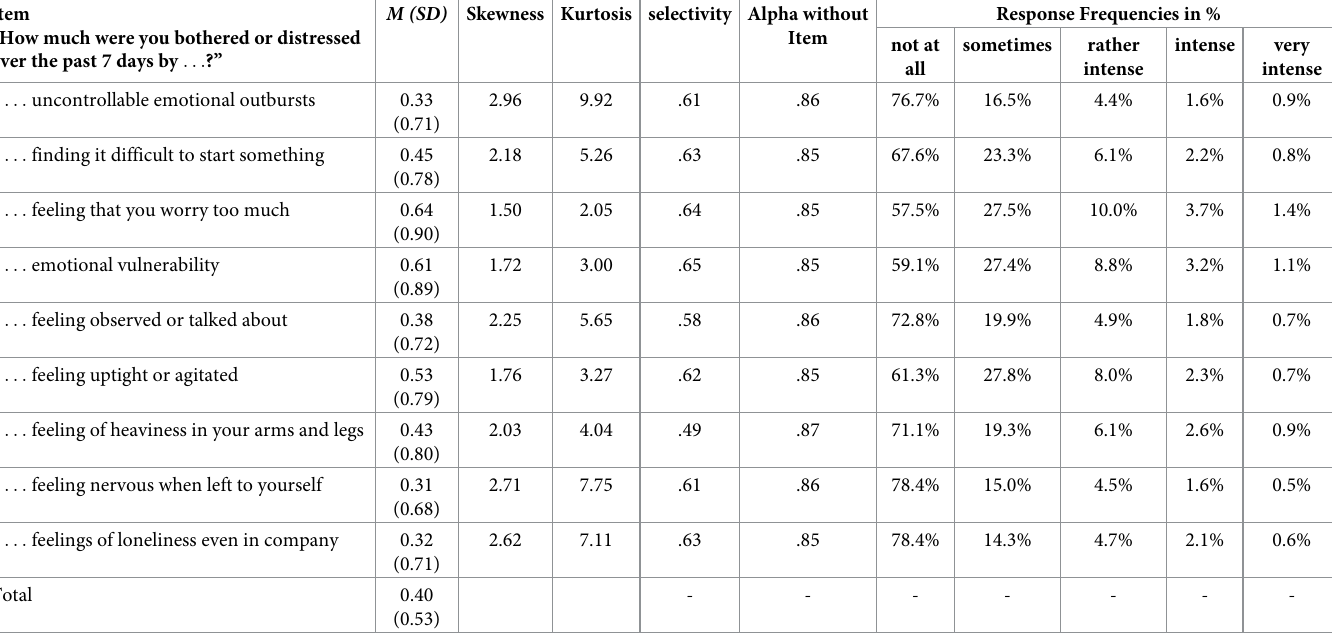
Table 3. Item characteristics, selectivity and response frequencies of the items. Item “How much were you bothered or distressed over the past 7 days by ... ?”